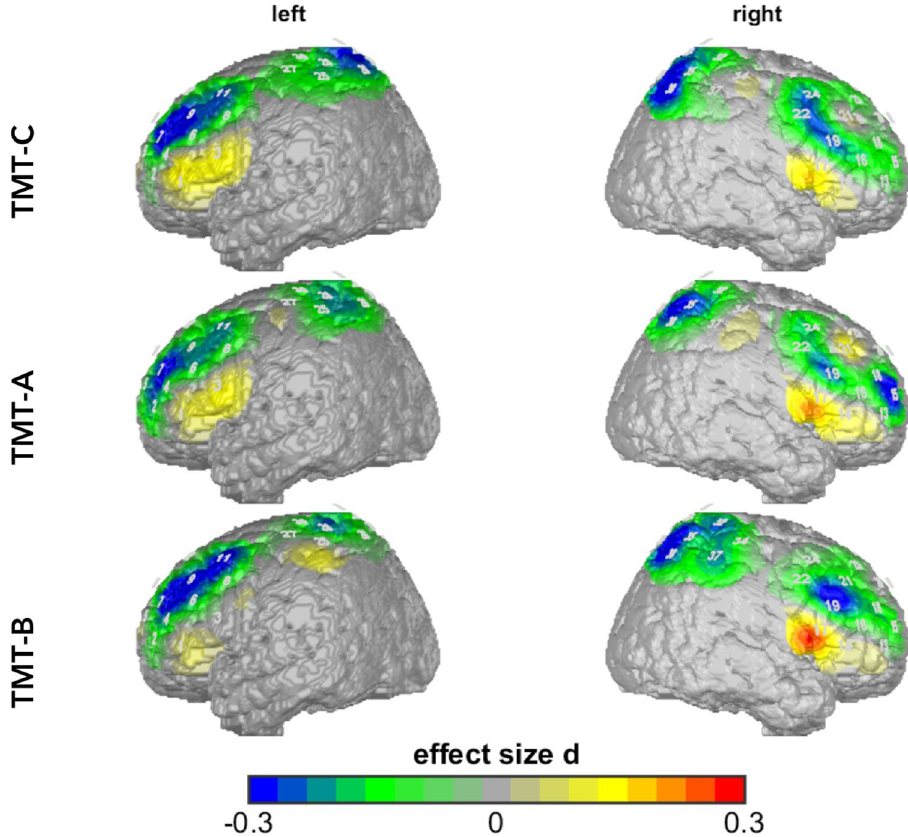
Figure 3. Time-corrected data (uncorrected O 2 Hb values): age effects (participants age < 66 vs.participants age ≥ 66) in TMT-A, TMT-B and TMT-C. Older participants showed higher activity compared to younger participants. Differences are shown in effect size Cohen’s